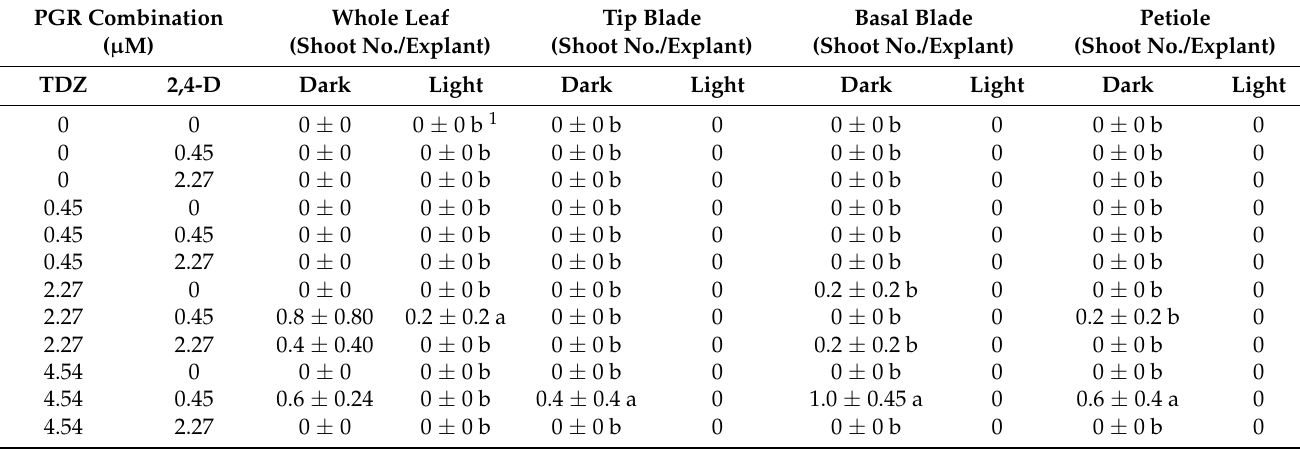
Table 5. Effect of the thidiazuron (TDZ) and 2,4-dichlorophenoxyacetic acid (2,4-D) combination on the number of shoot inductions from different strawberry ( Fragaria vesca ) explants after 4 weeks of